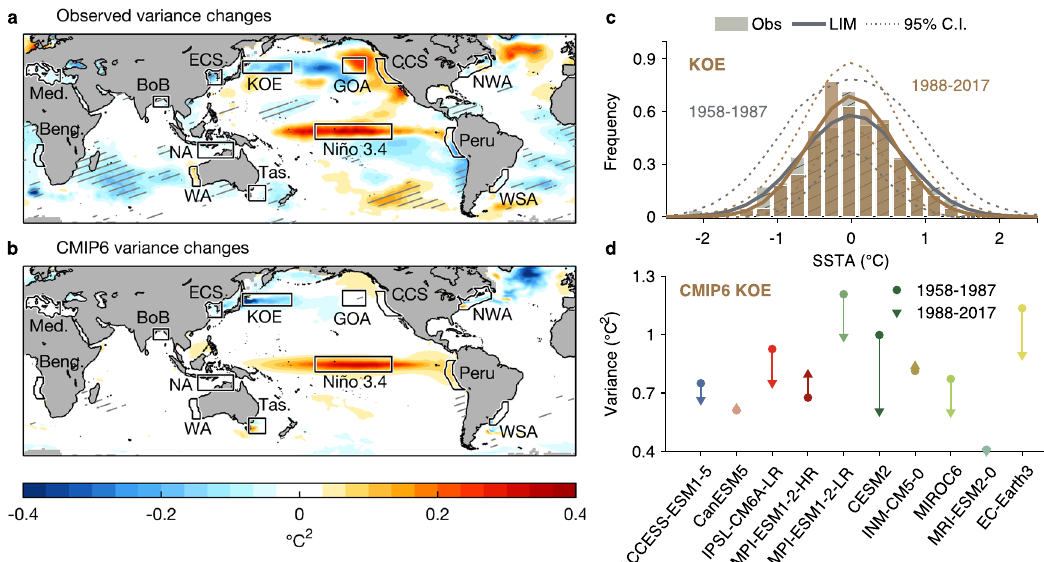
Fig. 4| Changesofdetrended SeaSurfaceTemperature(SST)varianceover the historical period. a Observed and b CMIP6-simulated variance changes from 1958 – 1987to1988 – 2017,inunitsof(°C) 2 .Hatchedregionsindicatelocationswhere the observed variance changes are signi fi cant, i.e., outside the 95% range of var- iance changes derived from a the LIM5817 ensemble, and b CMIP6. c Probability DistributionFunctions(PDFs)ofdetrended SSTAnomaly(SSTA)during1958 – 1987 (gray) and 1988 – 2017 (orange) in the Kuroshio-Oyashio Extension (KOE) region.